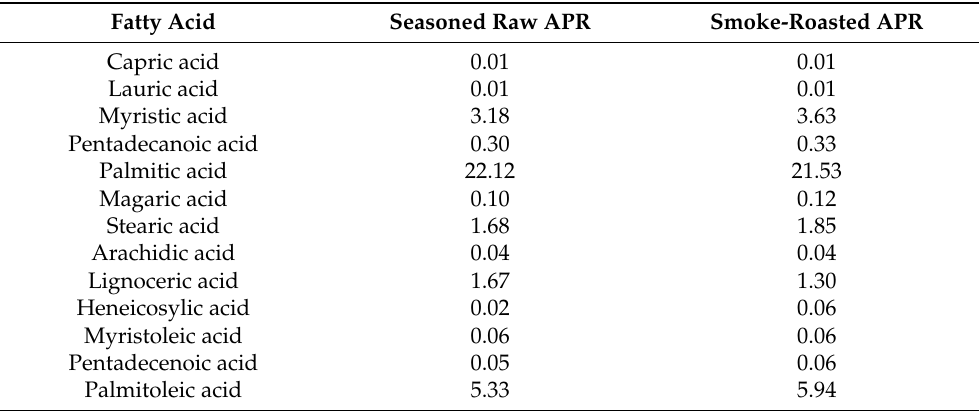
Table 7. Lipid profile of seasoned raw and smoke-roasted Alaska pollack roe (APR) (% of total